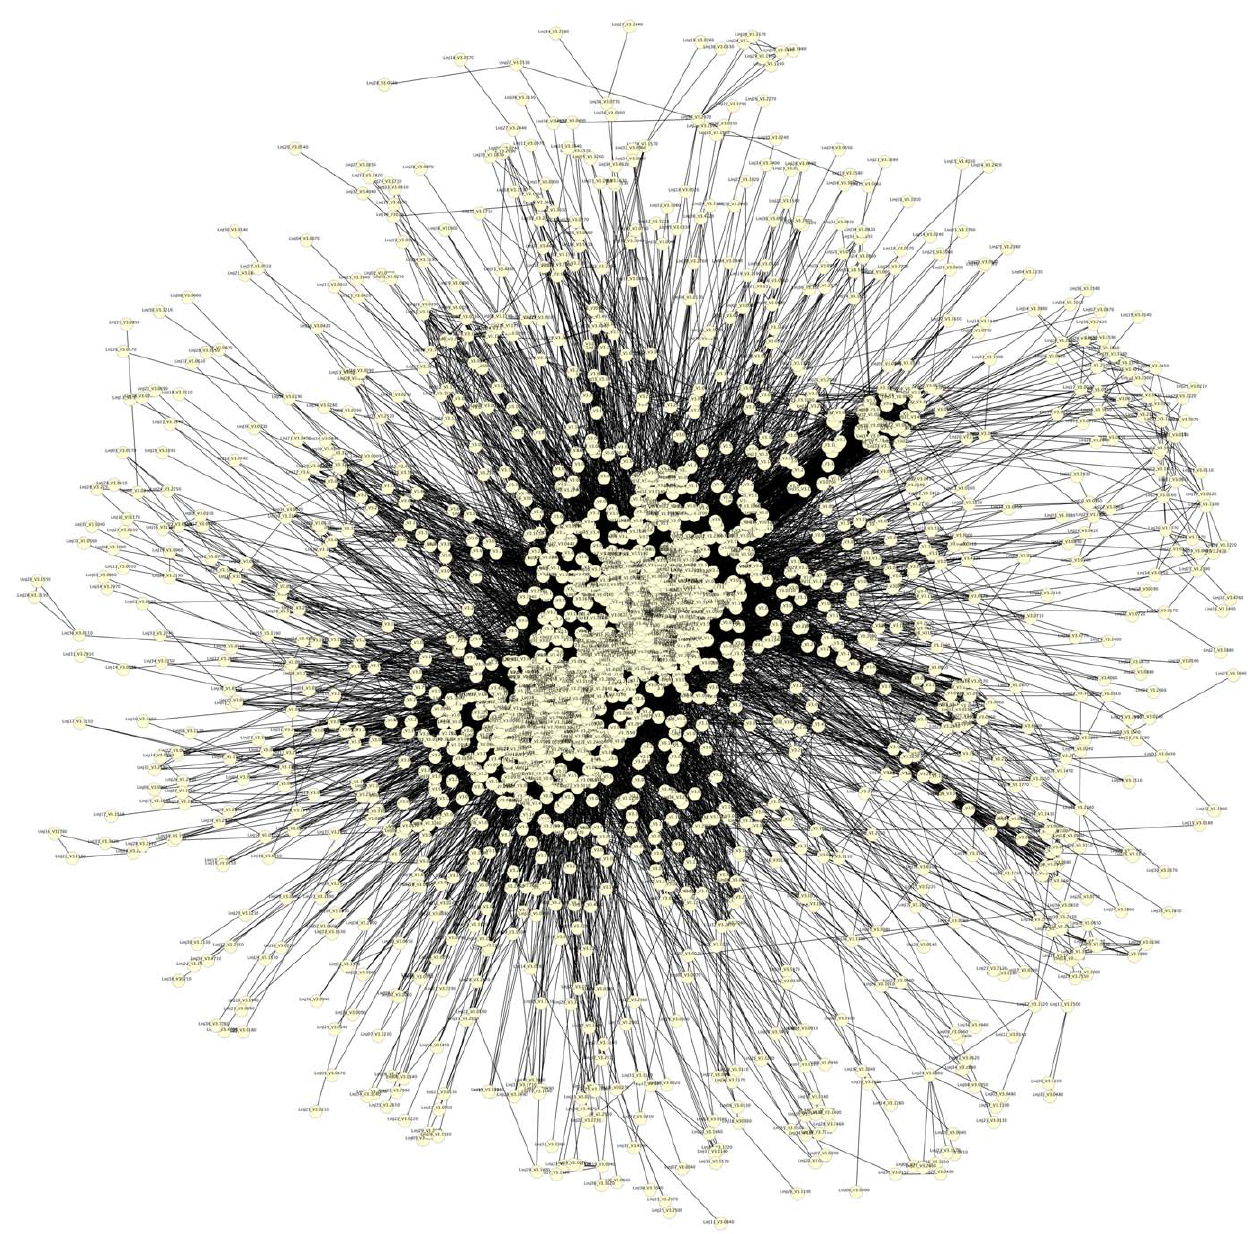
Figure 2. Protein-Protein Interaction for L.infantum visualized using Cytoscape 2.8.3 and the Edge-weighted spring embedded layout. doi:10.1371/journal.pone.0051304.g002 PLOS ONE |